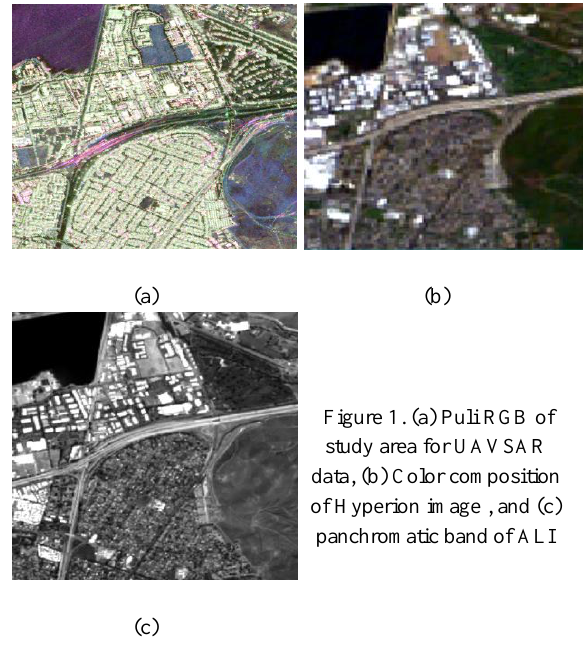
Figure 1. (a) Puli RGB of study area for UAVSAR